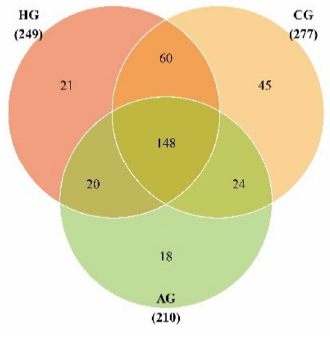
Figure 2. Venn diagram of the 3